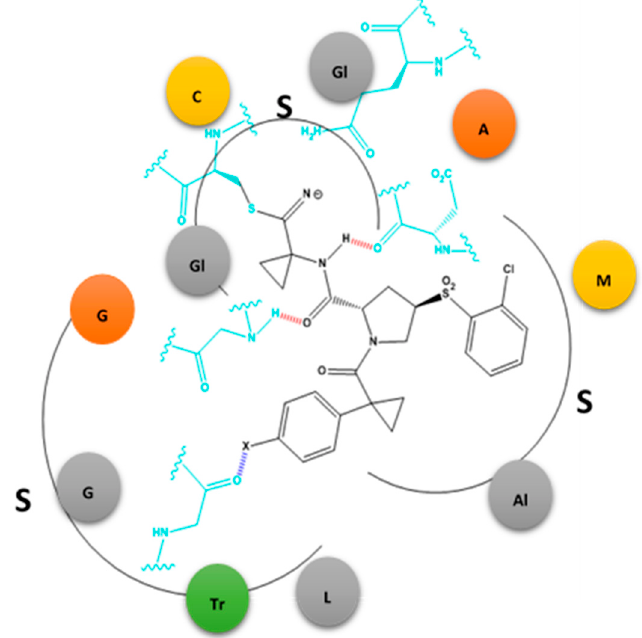
Figure 4. The docking of covalent inhibitors to hCatL (possessing three pockets). The chemical moiety at C4 benzyl is in the 3rd pocket (S3). And approaches the oxygen Lewis base of the carbonyl of Gly 61. If the halogen is Cl, Br, or I, the bond strength increases, resulting in enhanced binding affinity. Figure has been created using data from [15].